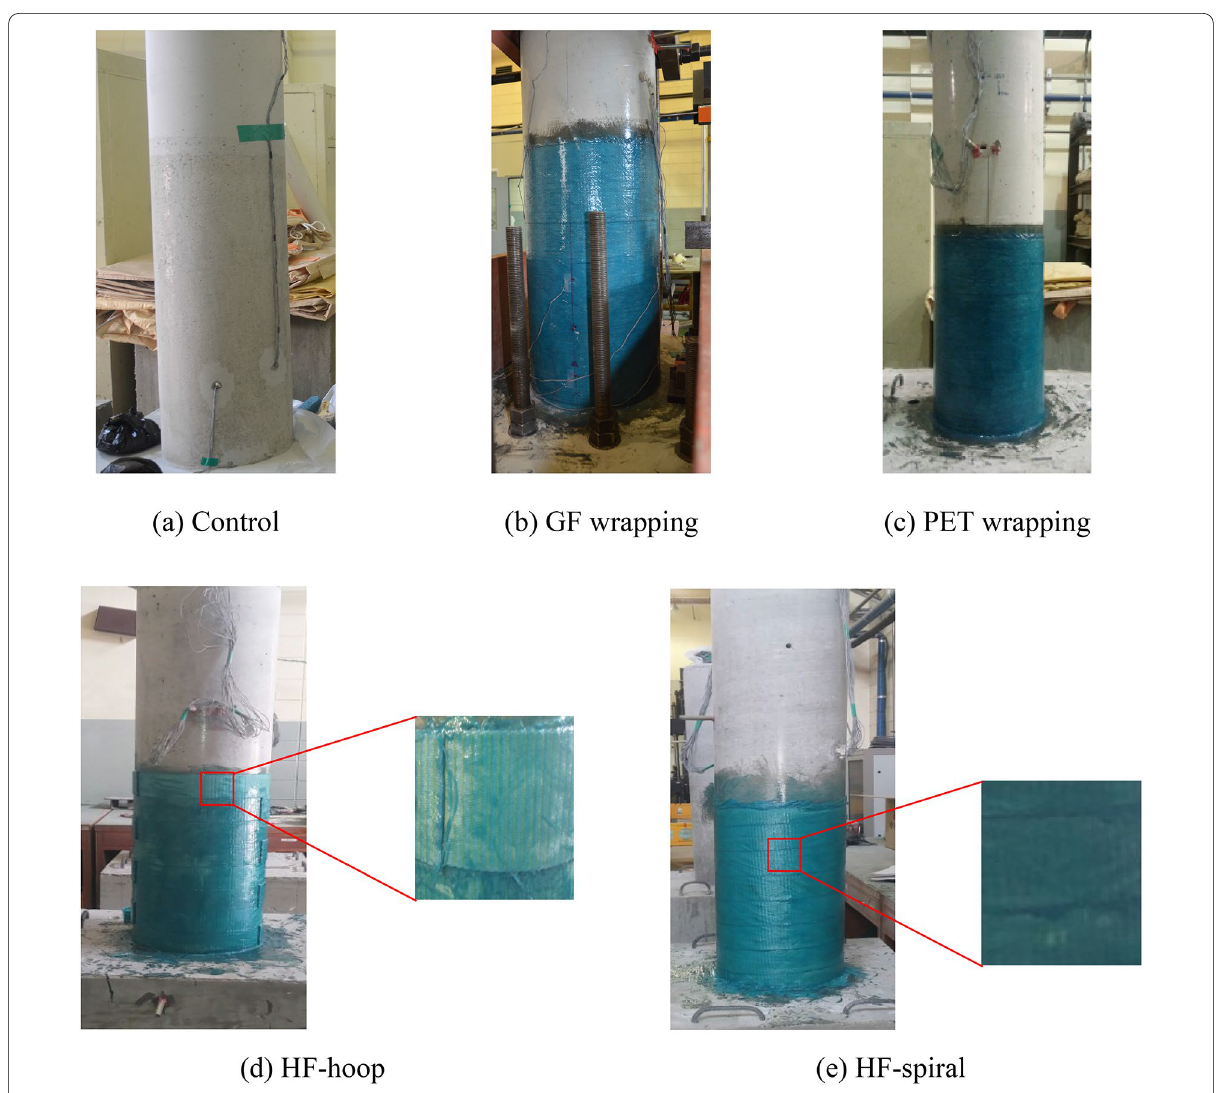
Fig. 3 Control specimen and fibers wrapped